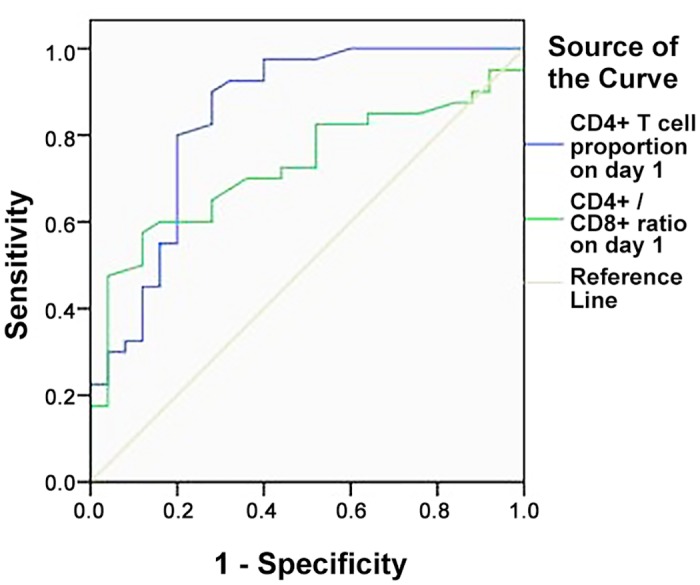
ROC curve of CD4+ T cell proportion versus CD4+ / CD8+ ratio on day 1 in predicting ACS.